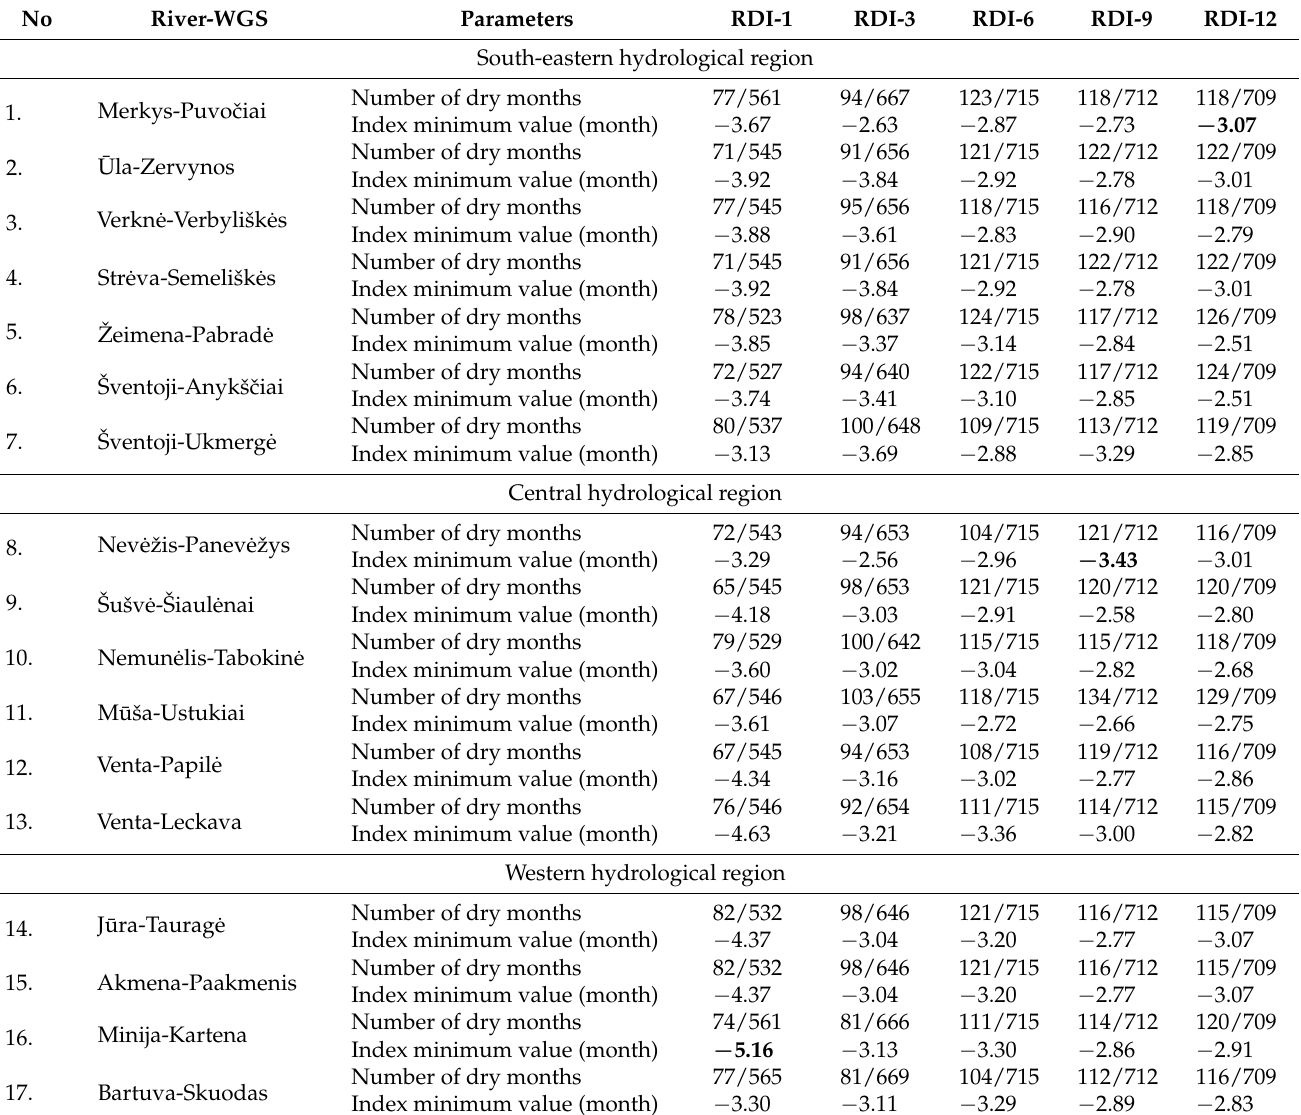
Table A2. RDI parameters which present the lowest value for each catchment.